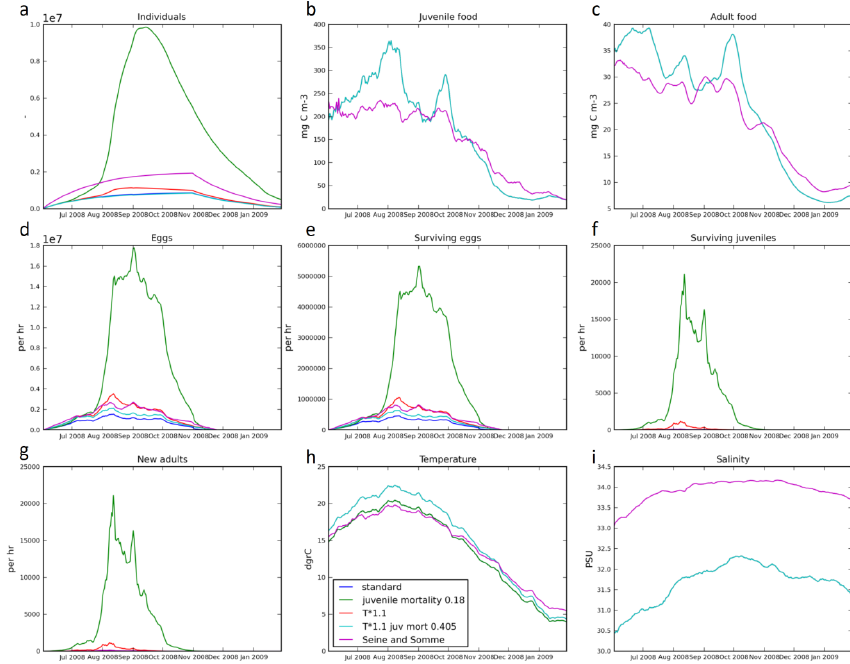
Figure 8. Cumulative results over all particles as a function of time for hindcast temperatures (dark blue), 1.1 times hindcast temperatures (red), two-thirds of juvenile mortality (green), combined 1.1 times hindcast temperatures and four-thirds of juvenile mortality (light blue), and release from the Seine and Somme (magenta). (a) Simulated number of M. leidyi individuals; (b) average juvenile food concentration available to particles [mg C m − 3 ]; (c) average adult food concentration available to particles [mg C m − 3 ]; (d) total number of eggs released per hour; (e) total number of surviving eggs per hour; (f) total number of surviving juveniles per hour; (g) total number of adults added to the population through reproduction per hour; (h) average temperature experienced by the particles; (i) average salinity experienced by the